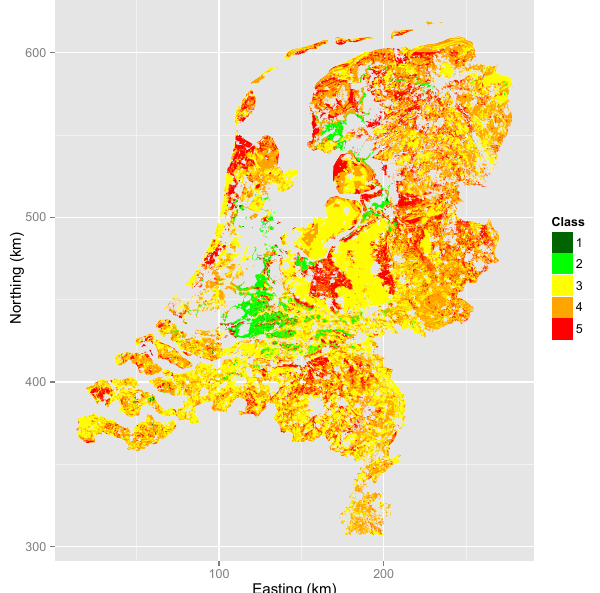
Figure 1. Map of risk for subsoil compaction (van den Akker et al.,